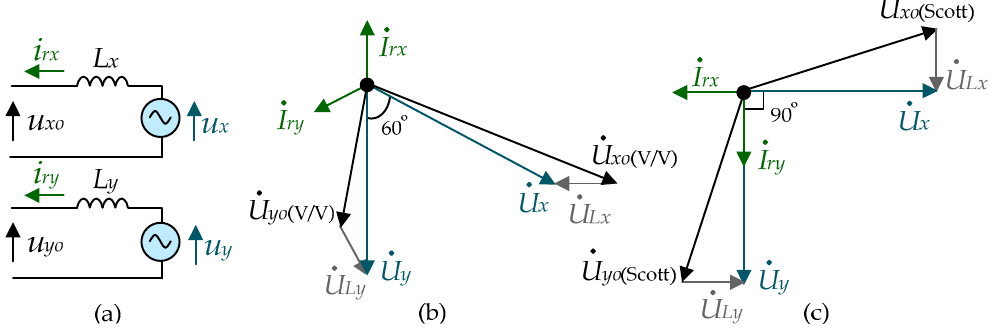
Figure 19. RPC output equivalent circuit and phasors of output voltages: ( a ) output equivalent circuit of the RPC; ( b ) phasors of the RPC output voltages in V/V power transformer; and ( c ) phasors of the RPC output voltages in Scott power transformer (based on [10]).